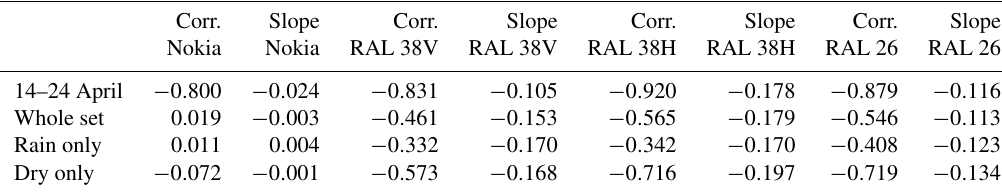
Table 3. Results of the regression of Fig. 11 applied to different subsets of the data. Corr. Slope Corr. Slope Corr. Slope Corr. Slope Nokia Nokia RAL 38V RAL 38V RAL 38H RAL 38H RAL 26 RAL 26 14–24 April − 0 . 800 − 0 . 024 − 0 . 831 − 0 . 105 − 0 . 920 − 0 . 178 − 0 . 879 − 0 . 116 Whole set 0.019 − 0 . 003 − 0 . 461 − 0 . 153 − 0 . 565 − 0 . 179 − 0 . 546 − 0 . 113 Rain only 0.011 0.004 − 0 . 332 − 0 . 170 − 0 . 342 − 0 . 170 − 0 . 408 − 0 . 123 Dry only − 0 . 072 − 0 . 001 − 0 . 573 − 0 . 168 − 0 . 716 − 0 . 197 − 0 . 719 − 0 .